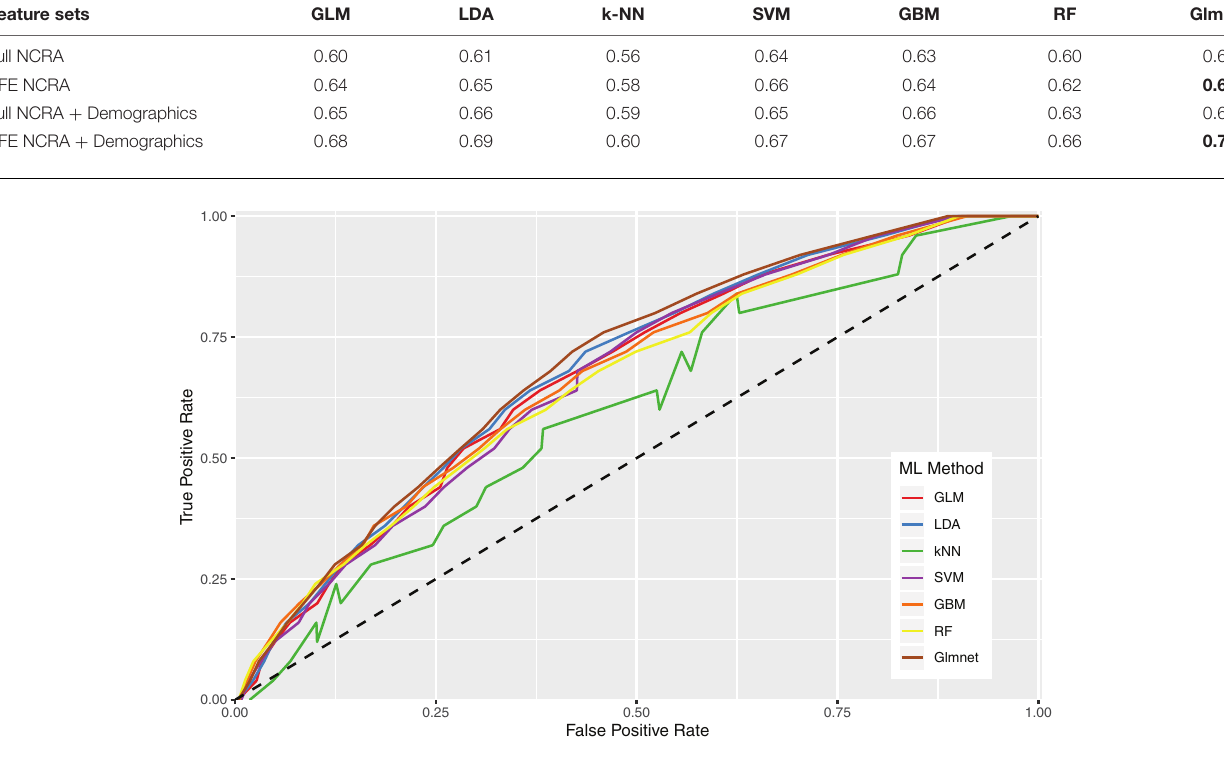
FIGURE 2 | Receiver operating characteristic curves illustrating predictive performance of all machine learning algorithms when looking at the RFE NCRA + Demographics feature set.